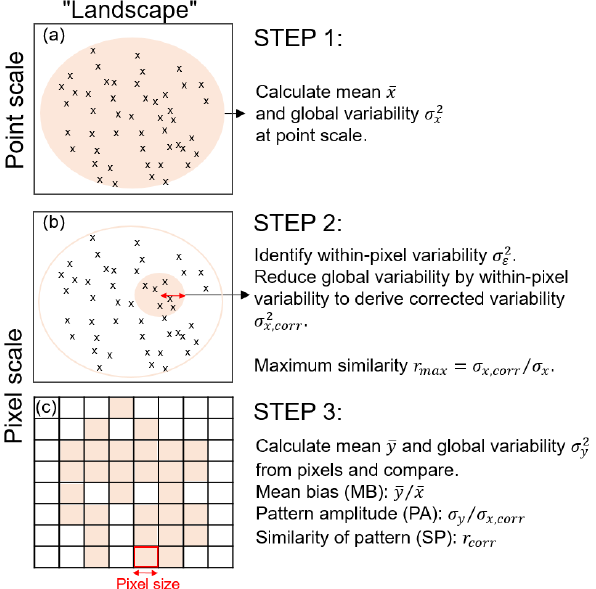
Figure 1. Schematic overview of the three steps in the pixel-to- point comparison. Note that we refer to “landscape” as the region of interest for which point and pixel data are available. (a) The mean and global variability at the point scale are calculated from all plots across the landscape; (b) the within-pixel variability is calculated from all plots within the distance of the pixel size (i.e. the red arrow corresponds with pixel size); (c) the mean and global variability is calculated from the pixel values and the three comparison metrics are derived. Note: a block bootstrapping with 10000 repetitions is performed to derive confidence intervals of the comparison